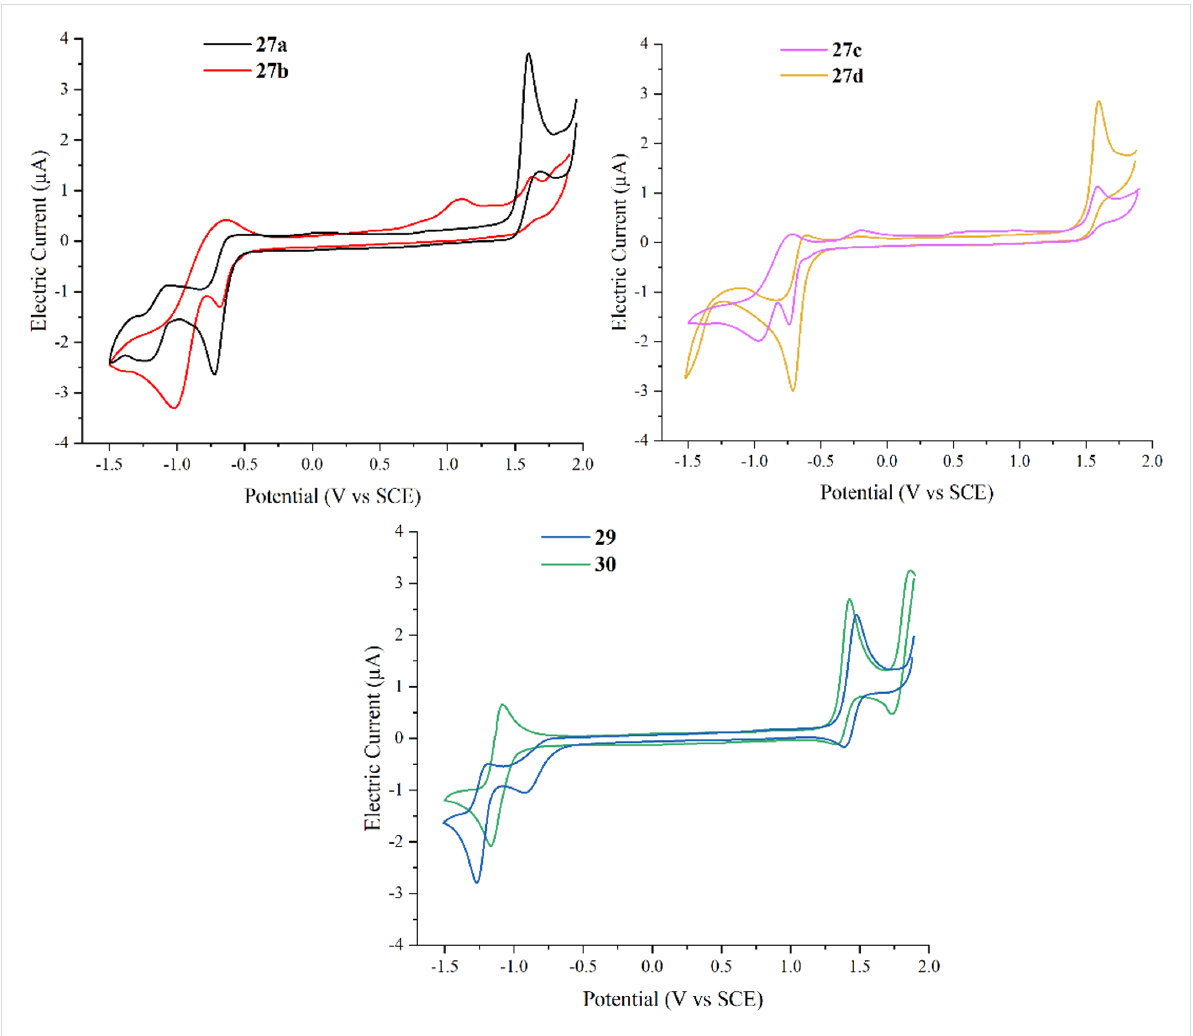
Figure 2: Cyclic voltammetry traces for rhenium complexes 27a – d , 29 and 30 : 0.5 mM in MeCN solution with 0.1 M Bu 4 NPF 6 under nitrogen at 25 °C, recorded at 0.1 V/s at a glassy carbon electrode and referenced to the saturated calomel electrode (SCE) using Fc/Fc + as an internal stan- dard (0.46 V vs SCE [12]).